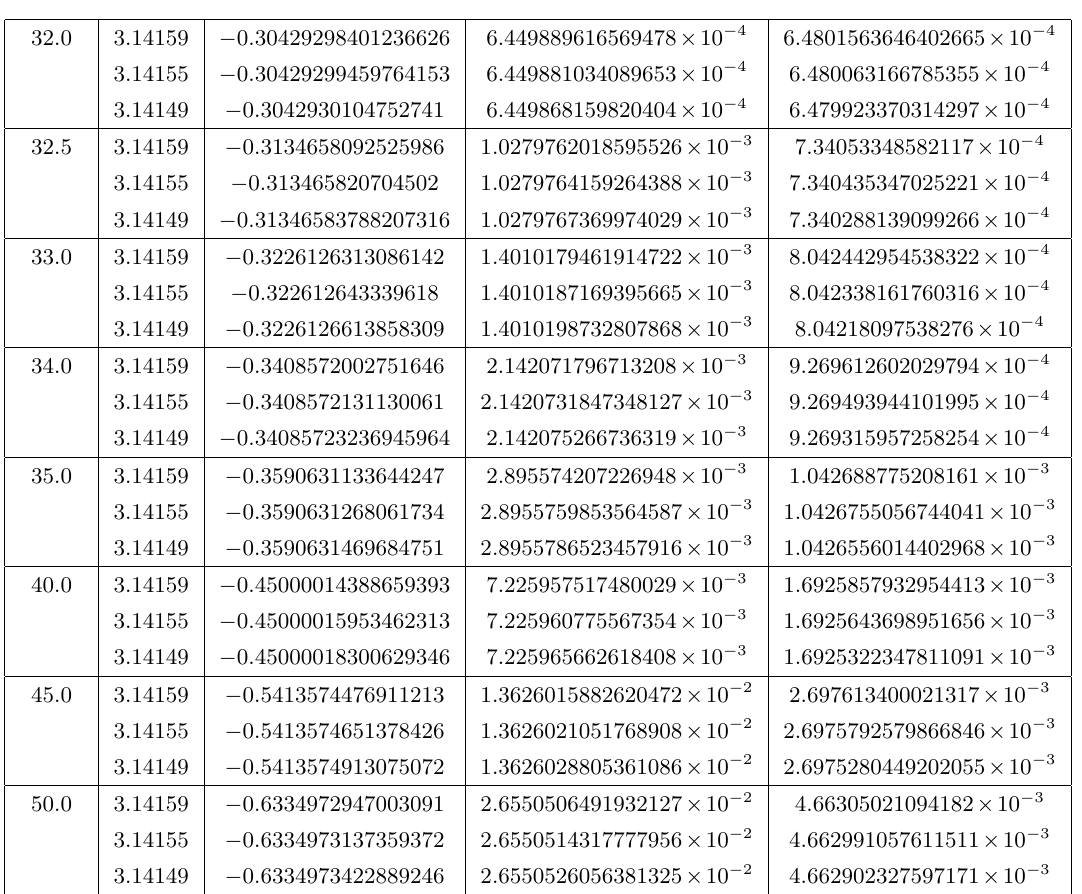
Table 6. N = 70 , partial phase at finite θ